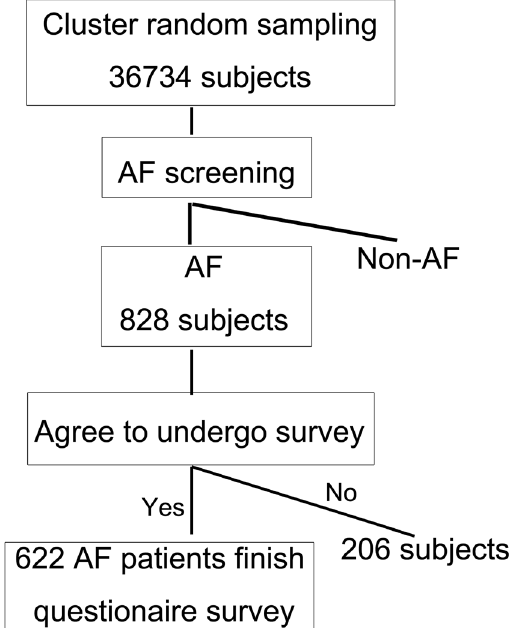
Figure 1. The consort diagram of the study population. AF, atrial